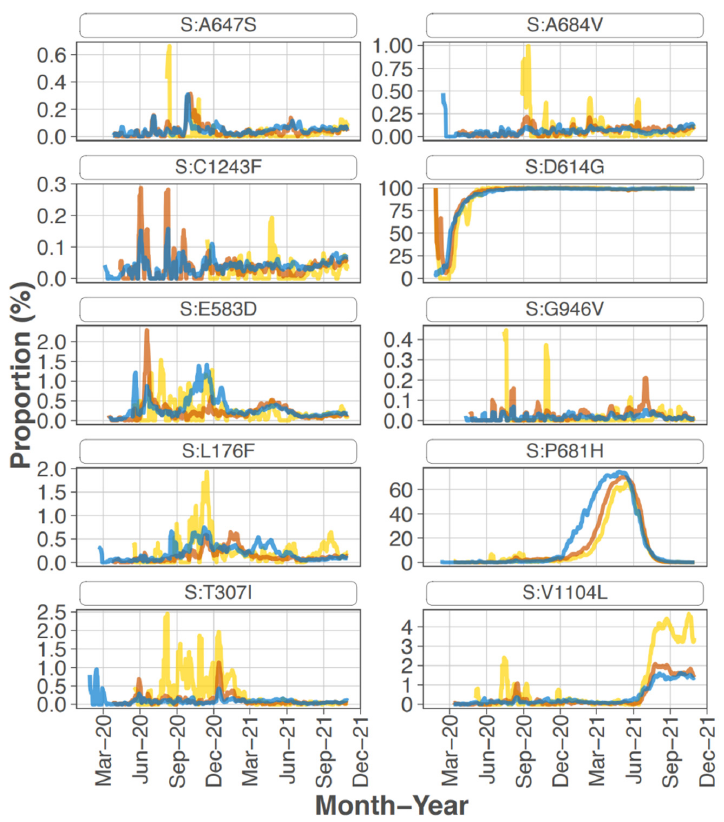
Figure 3. Prevalence of the highest ranked mutations in the spike gene over the course of the pandemic. Each graph represents the 7 day rolling average of the percent positive sequences for each highest ranked mutation (data obtained from outbreak.info with analysis period through October 2021). Table 2. Highest and lowest-ranked S protein mutations. The 71 mutations detected in the S